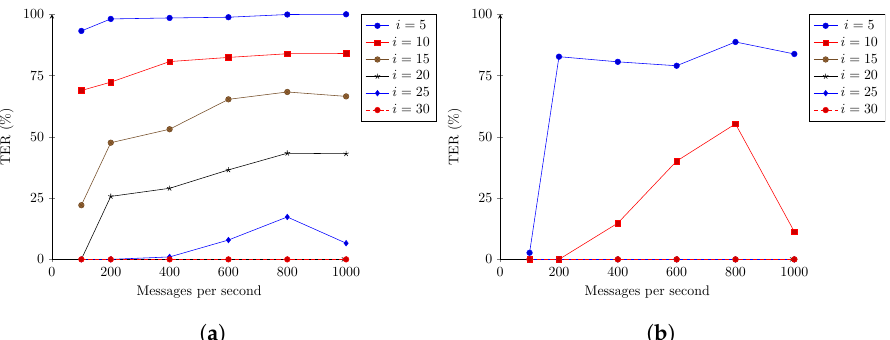
Figure 9. TER registered for the second stage—evaluation. ( a ) The 100 simulated devices and 1 IoTAgent-LoRaWAN, as in Figure 7. ( b ) The 100 simulated devices and 3 IoTAgent-LoRaWAN, as in Figure